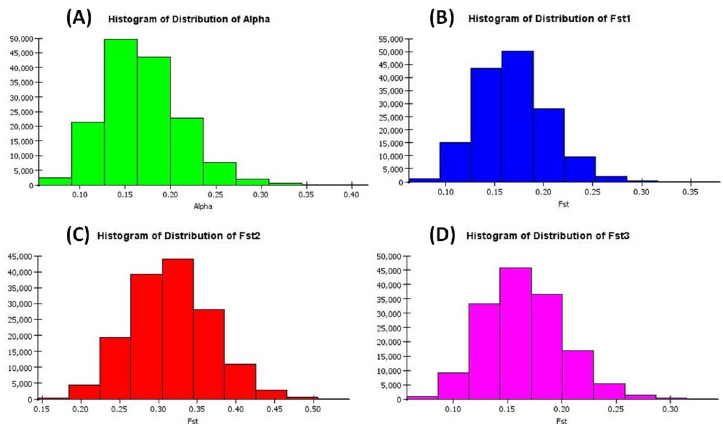
Fig 4. Distribution of (A) Alpha value in panel (B) F st values obtained for subpopulation 1; (C) Fst values obtained for subpopulation 2 and (D) F st values obtained for subpopulation 3.